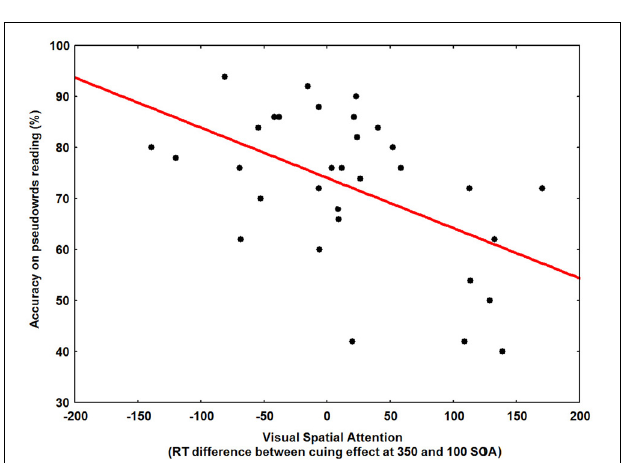
FIGURE 6 | Scatter plot of the relationship between time-course of visual spatial attention (RT difference between cuing effect at 350 and